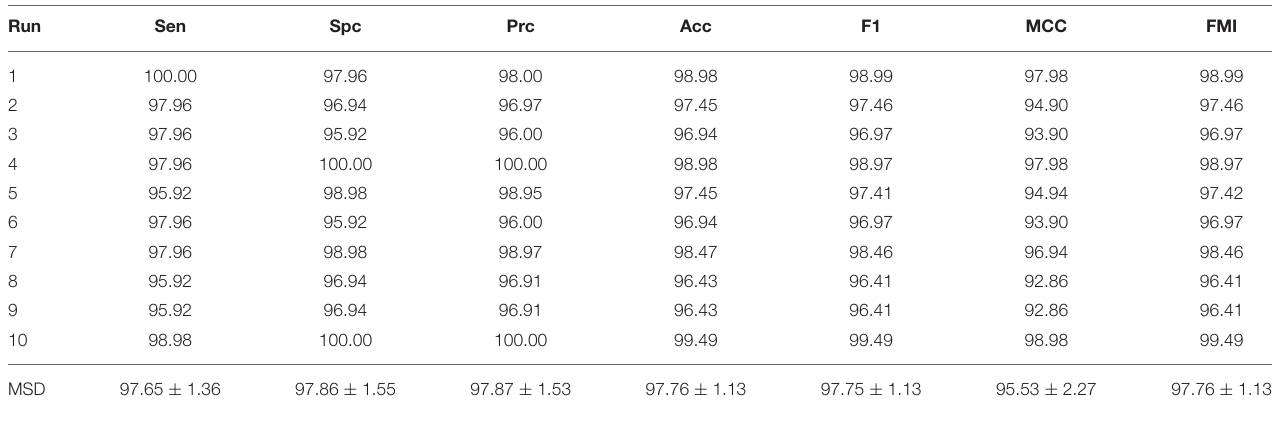
TABLE 6 | Results of proposed ADVIAN